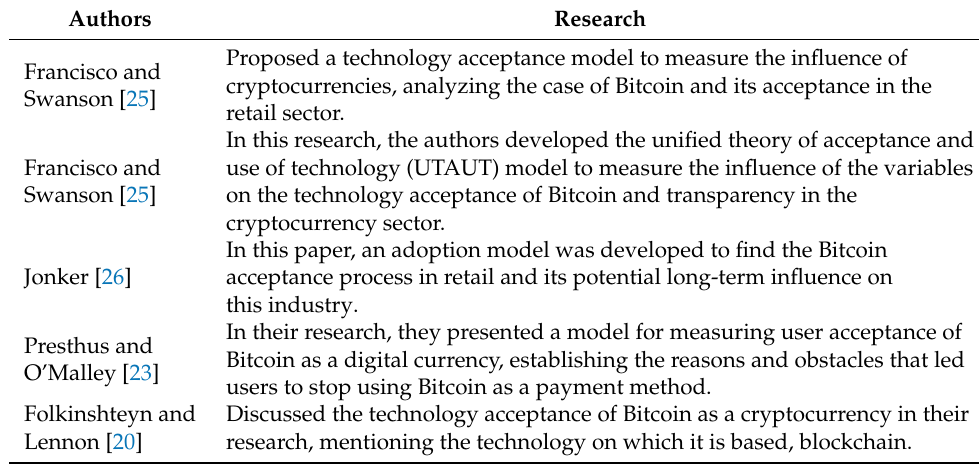
Table 1. Research on acceptance of Bitcoin as a